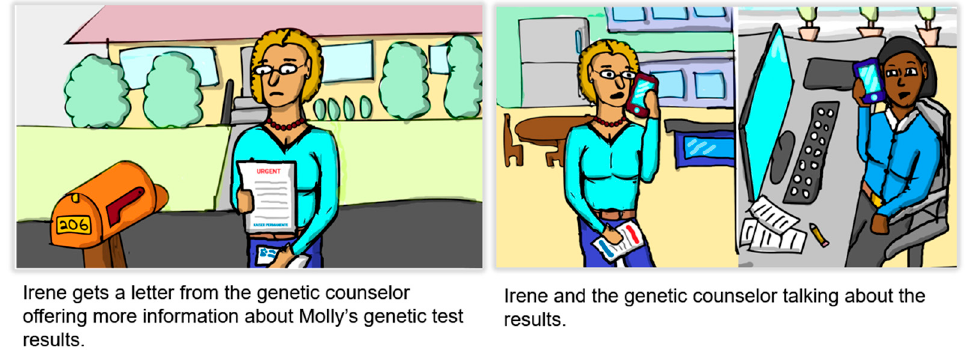
Figure 2. Screen shots of narrated video used in Round 2 depicting the draft direct contact program.